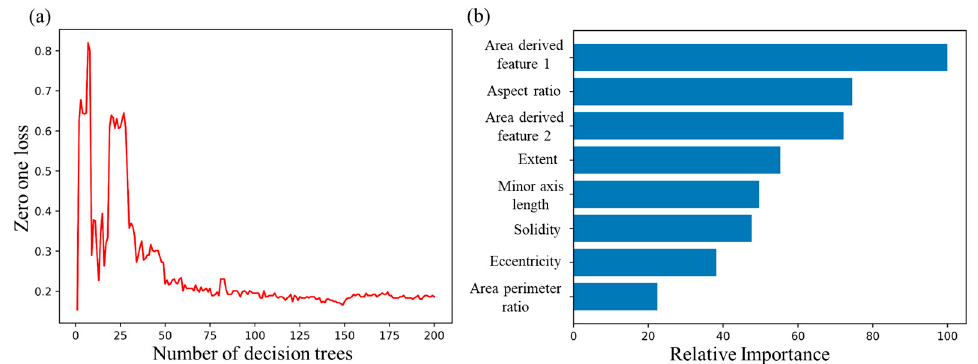
Figure 8. Parameter decision for the number of trees ( a ) and the relative importance of the eight features ( b ).